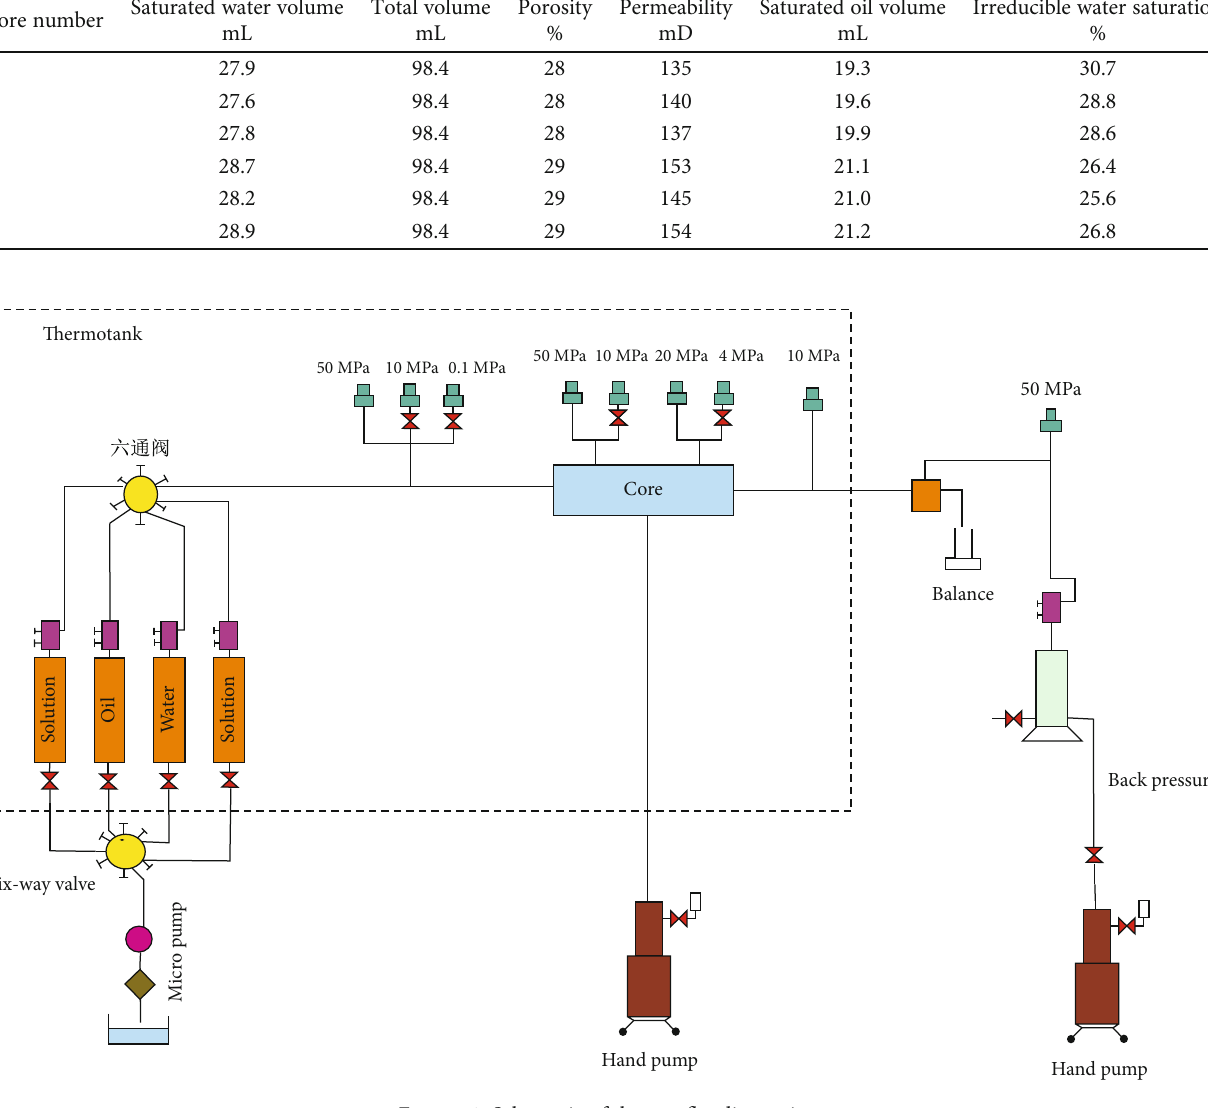
Figure 1: Schematic of the core fl ooding unit. Table 2: Core data